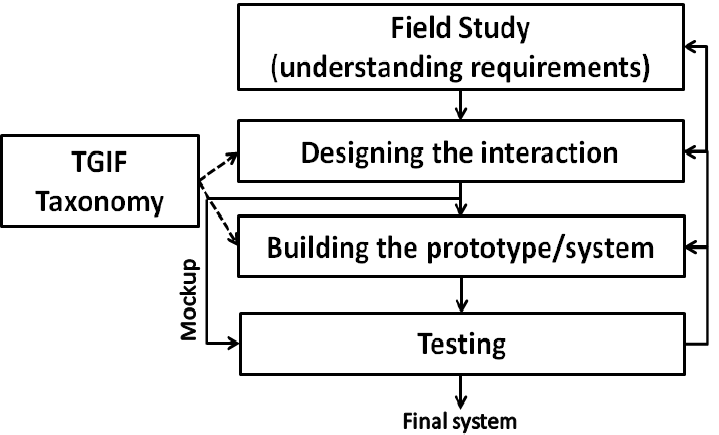
Figure 5. TGI design